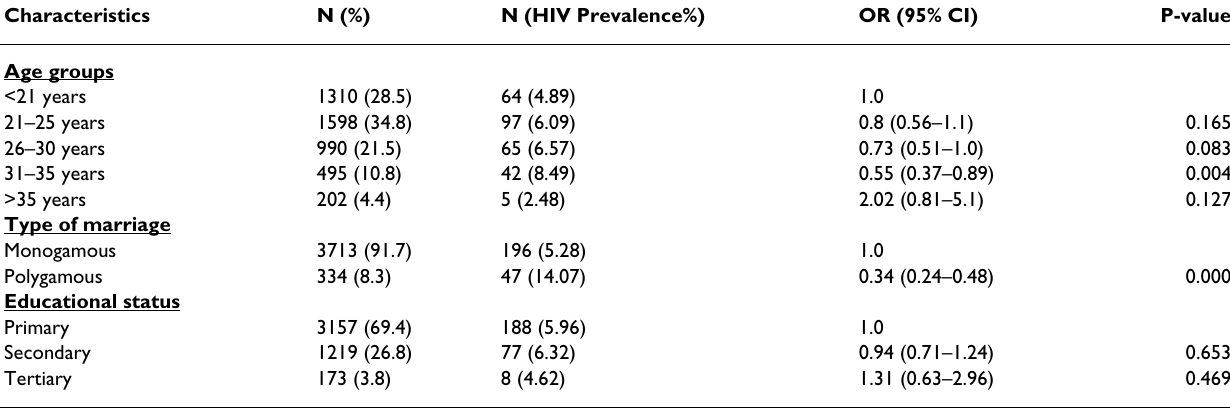
Table 3: Profiles of antenatal attendees associated with HIV infection